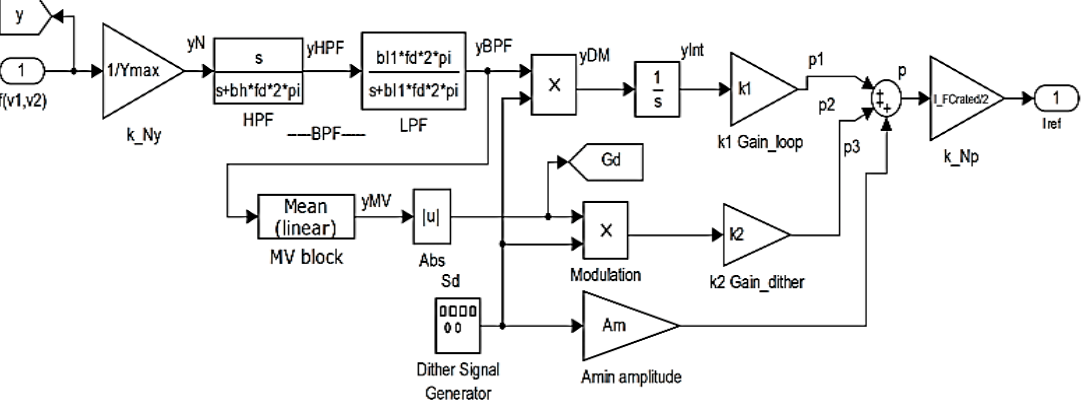
Figure 5. The diagram of the ESC scheme.